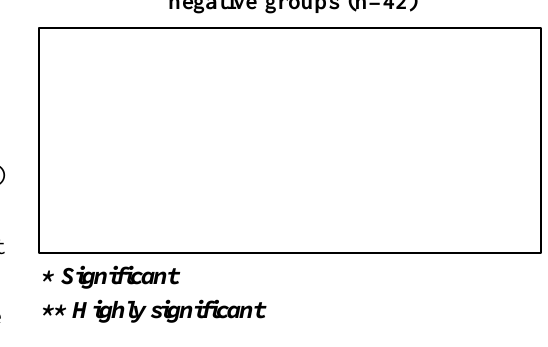
Peak exercise electrocardiographic characteristics of true-positive versus true-